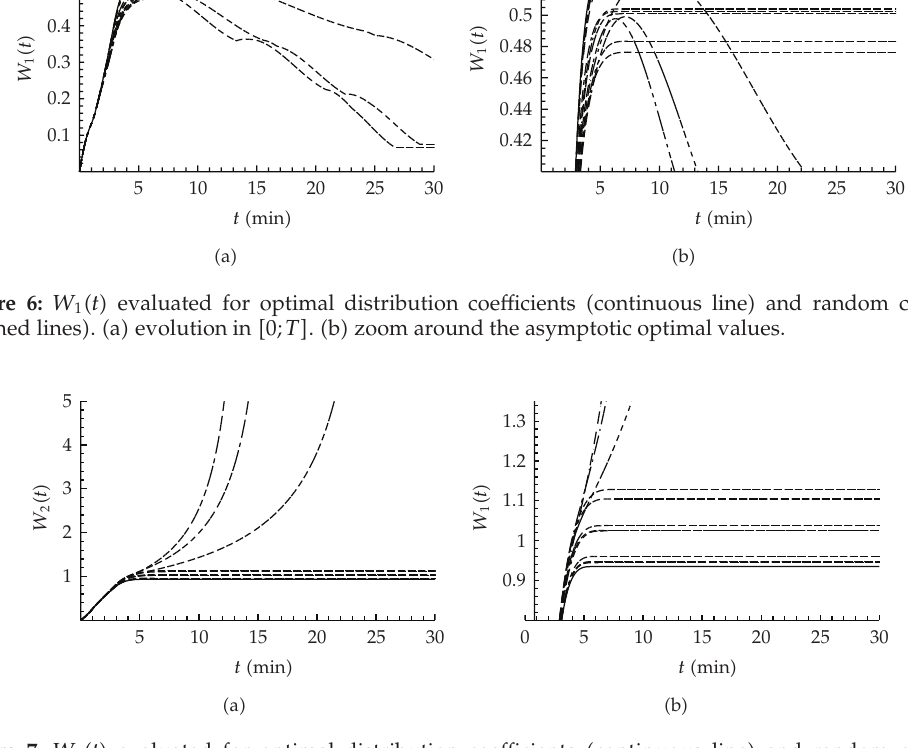
Via Leonino Vinciprova (cid:4) segments d and e (cid:7) , Via Settimio Mobilio (cid:4) segments f , g , h , and i (cid:7)